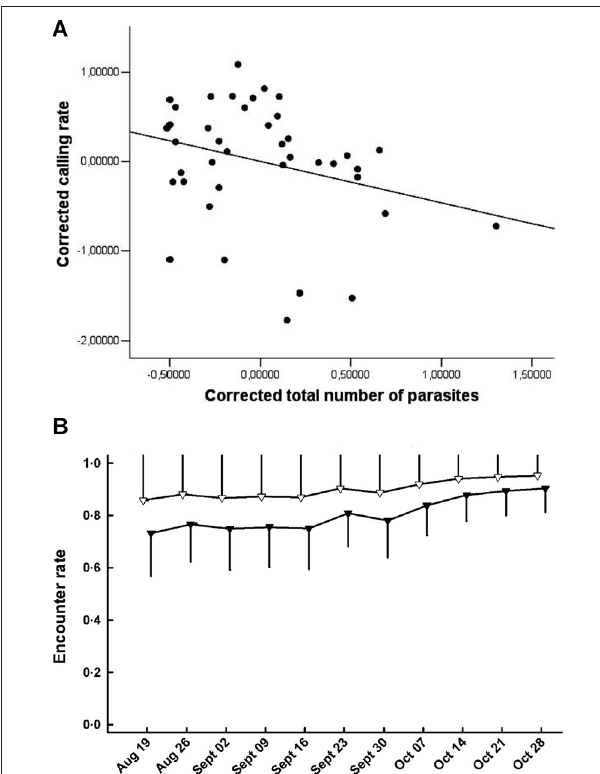
figURe 2 | (a) Relationship between parasite load (DNA copy number) and the probability of detecting Plasmodium infection by qPCR in blue tits ( Cyanistes caeruleus ). Dotted lines are 95% confidence intervals ( Adapted from ( 12 ), with the permission of John Wiley and Sons ); (B) relationship between infection with Bd and survival probability of male Litoria rheocola as a function of pathogen load: uninfected ( ○ ), 1–4 zoospores ( ● ) and >4 zoospores ( ) [Adapted from ( 29 ), with the permission of John Wiley and Sons